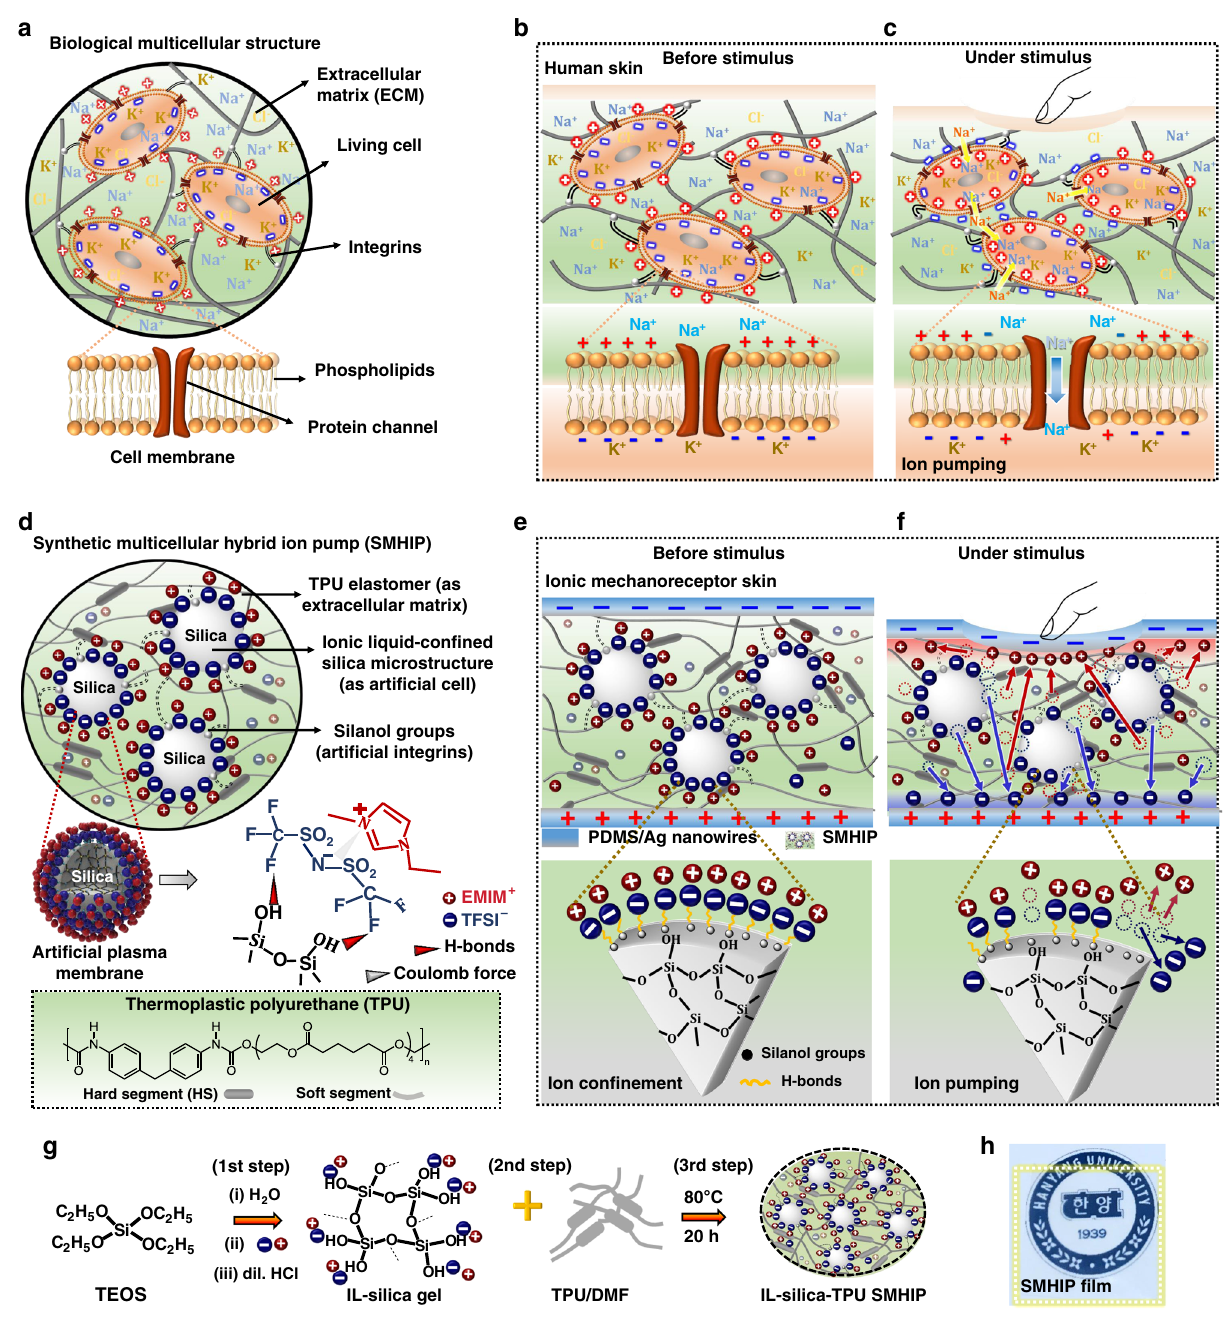
Figs. 2, 3) in different steps: (i) synthesis of IL – silica gel through sol-gel process and (ii) blending IL – silica gel and TPU/DMF mixture to obtain transparent tri-component solution (IL – silica – TPU), followed by various heat treatment processes to develop transparent cellular-structured IL – silica – TPU fi lms (Fig. 1h). In this work, 20 wt% is the optimized concentration to obtain the shape- and size-controlled IL-con fi ned silica micro- structures (termed as arti fi cial cells) well dispersed in the TPU polymer matrix (ECM) (Supplementary Note 2 and Supple- mentary Figs. 4 –